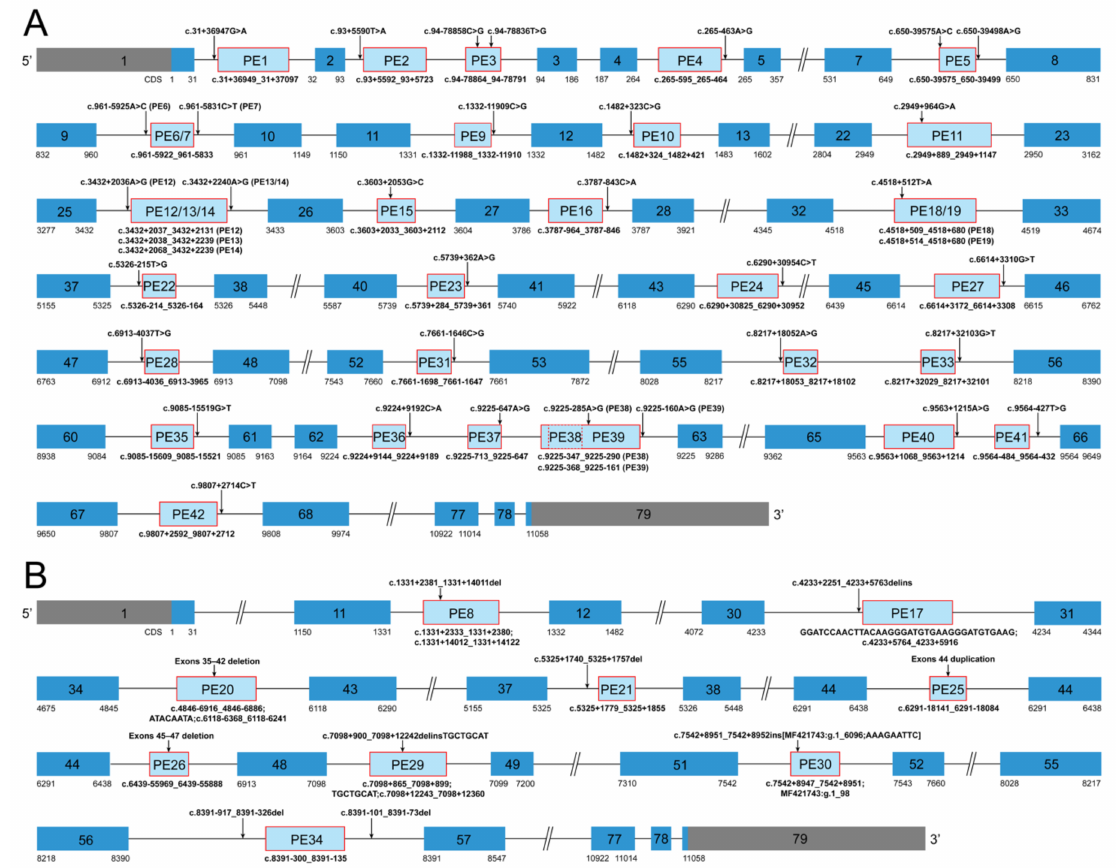
Figure 2. Graphic representation of the forty-two dystrophin pseudoexons. ( A ) Graphic representation of PEs activated by deep intronic single nucleotide variants in DMD . ( B ) Graphic representation of PEs introduced by small and large rearrangements in DMD . Each PE is shown as a light blue box, and its genomic coordinate is indicated under the light blue box. The PE-activating genomic variant of each PE is shown above an arrow. A dark blue box indicates a canonical exon. The more detailed genetic information about the PEs is provided in Table S2. PE, pseudoexon; ins, insertion; inv, inversion; dup, duplication; del, deletion; delins,